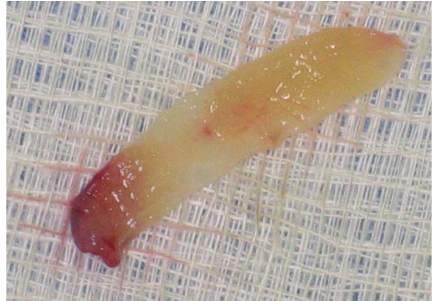
Figure 9: Radiograph showing stable peri-implant bone 3 months after